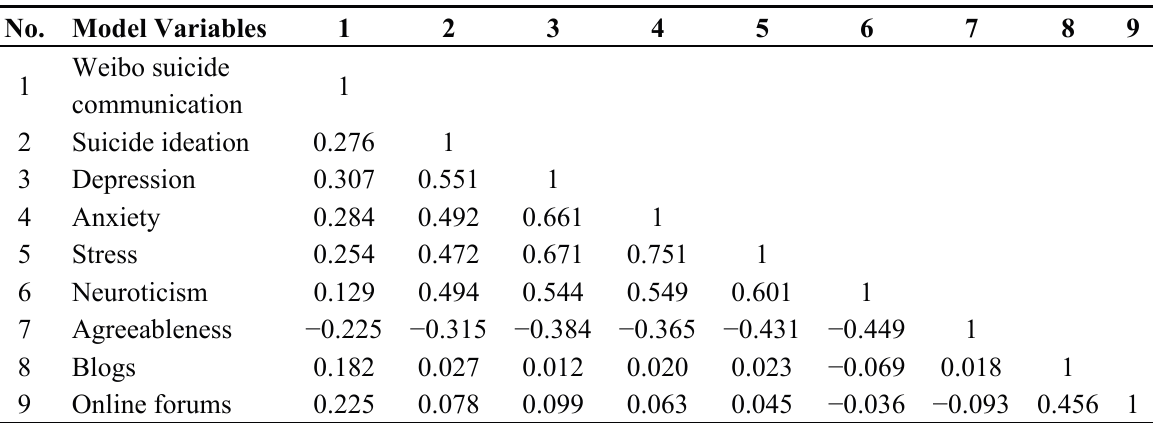
Table 4. Spearman’s rank